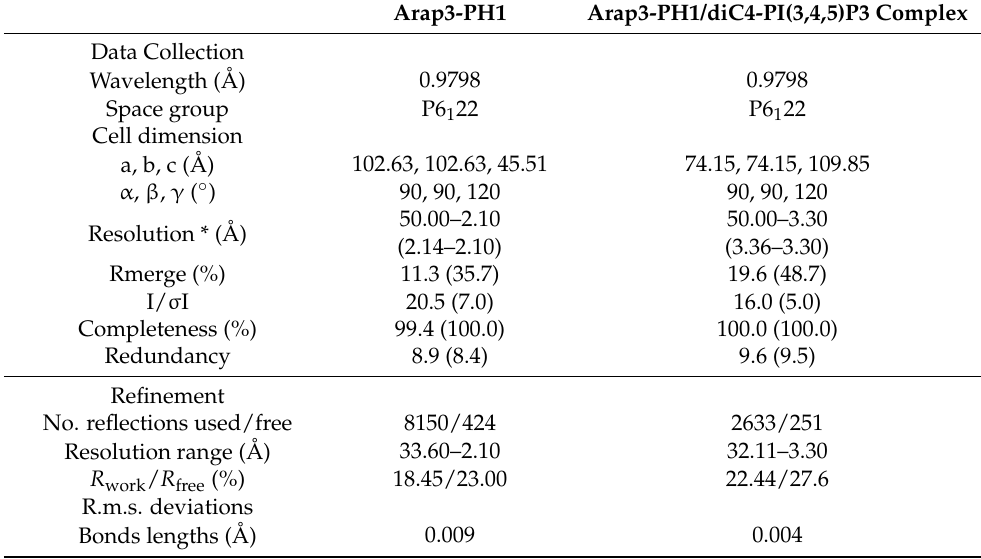
Table 1. Crystallographic data collection and refinement